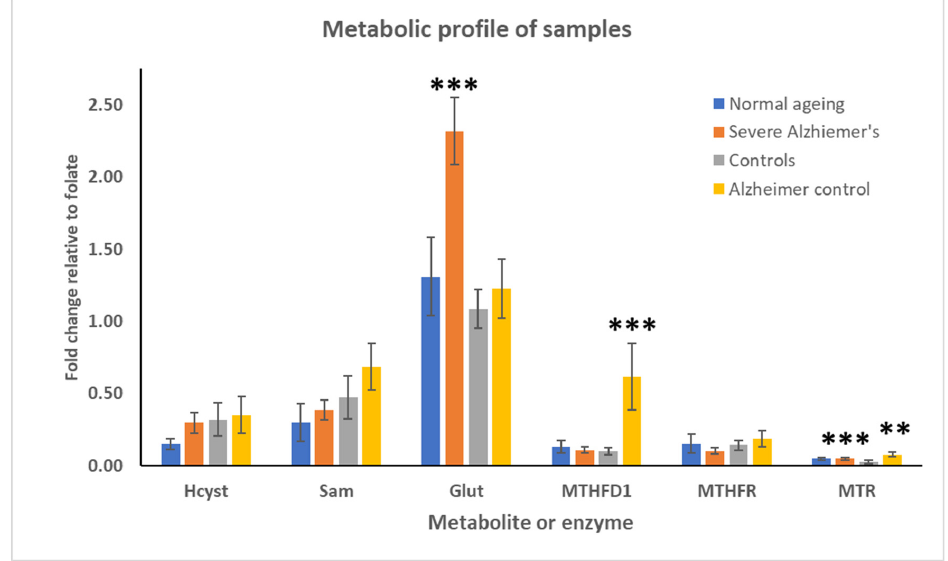
Figure 3. Metabolic profiles of samples analysed for key metabolites and enzymes plotted as fold of